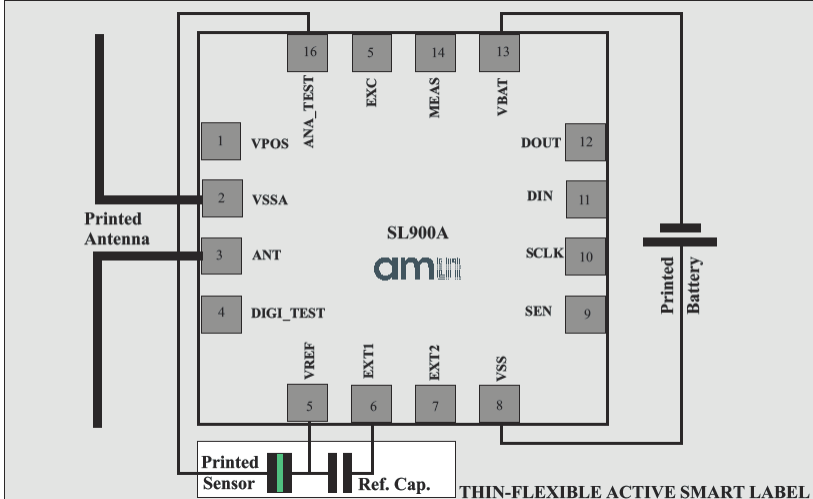
Figure 15. Practical-sensory tag application, based on SL900A smart label with integrated temperature sensor, real time shelf-life calculation and data logging capability, combined with external screen printed humidity sensor, and screen printed UHF